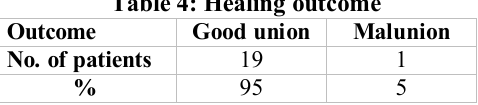
Table 4: Healing outcome